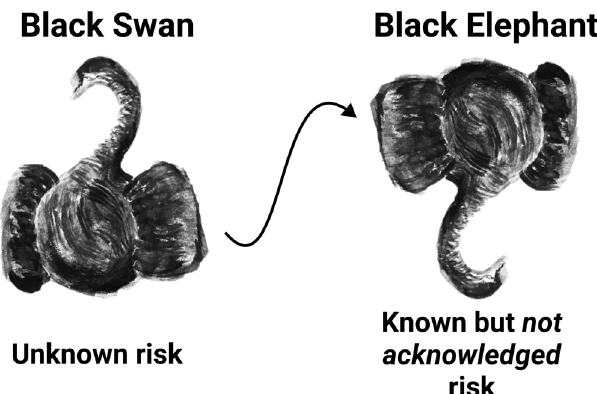
Fig. 1 One risk, two perspectives. Black Swans and Black Elephants both describe hazard events with high impact, high exposure, and high vulnerability but are viewed from two different vantage points. With knowledge but without acknowledgment, a Black Swan becomes a Black Elephant. Both have the potential for catastrophic